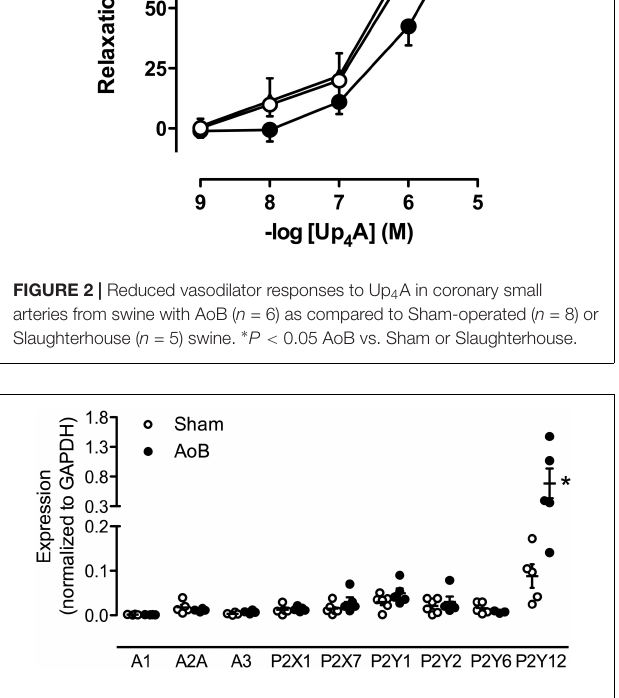
FIGURE 3 | mRNA expression of various P receptor subtypes in coronary small arteries from Sham-operated swine and swine with AoB. mRNA expression was normalized to expression of GAPDH. ∗ P < 0.05 vs.